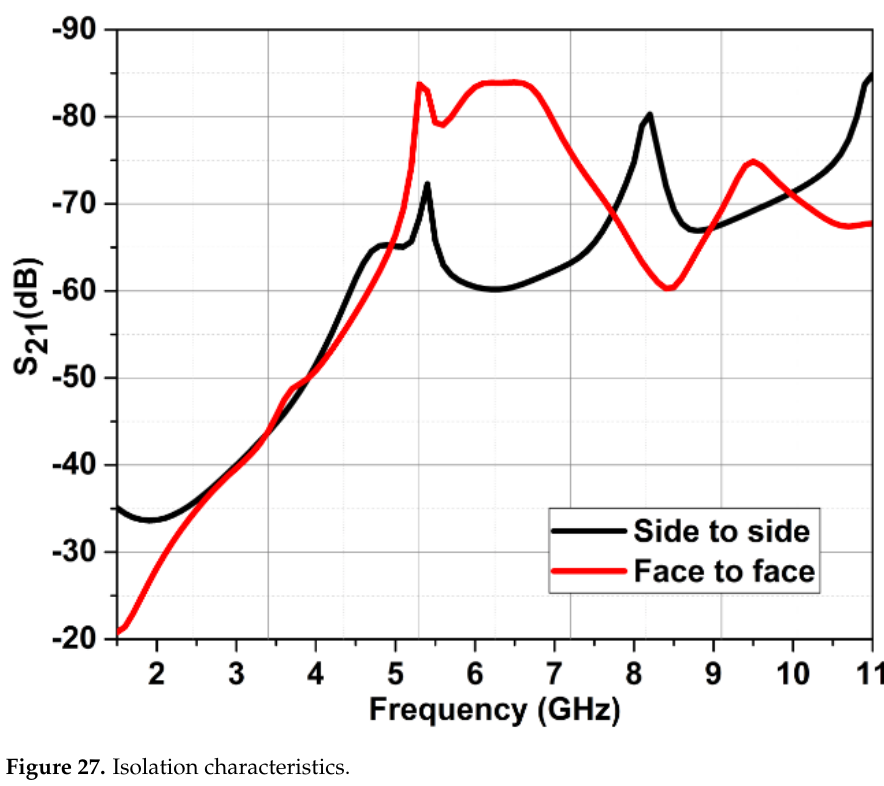
Figure 27. Isolation characteristics.